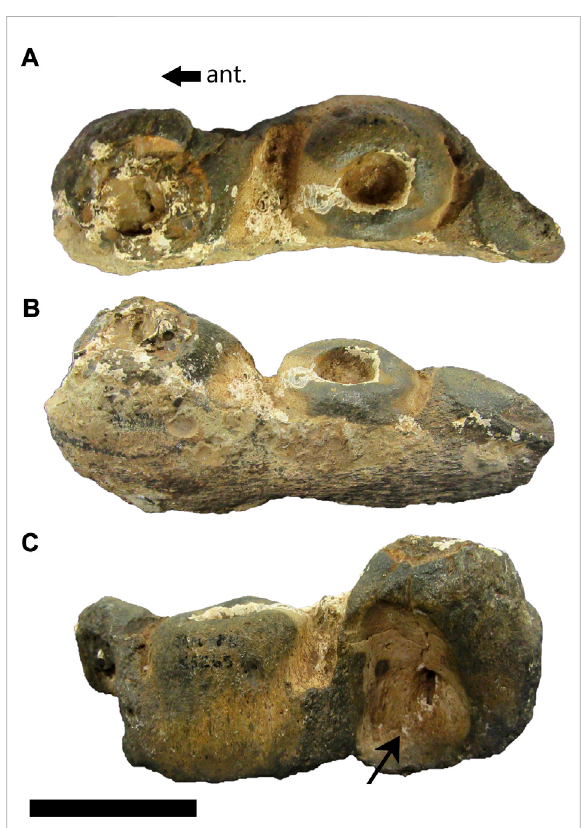
FIGURE 3 cf. Prognathodon (SAM-PK-5265)posteriordentaryfragment in dorsal (A) , lateral (B) and medial (C) views. Anterior (ant.) arrows pertain only to medial view. Black arrow in C points to large resorption pit visible on medial side. Scale bar = 50